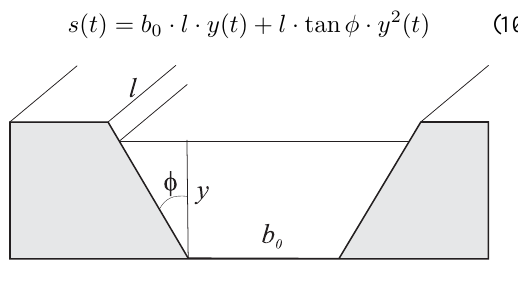
Fig. 2: Trapezoidal reservoir